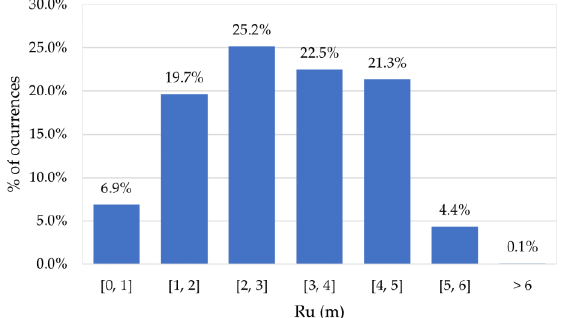
Figure 10. Intervals of run-up for the four scenarios.